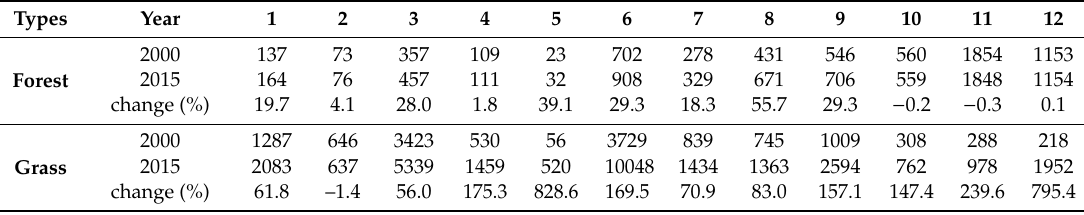
Table 3. Vegetation (Forest and Grass) change rates throughout the 12 watersheds in 2000 and